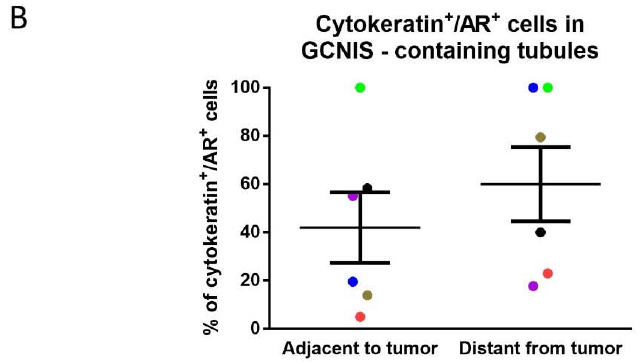
Figure 8. ( A ) Cytokeratin (blue), POU5F1 (GCNIS; red), and androgen receptor (AR, green) expression in Sertoli cells from GCNIS-containing tubules located distant from the tumour and adjacent to the tumour. Dashed lines represent the periphery of the seminiferous tubules. Scale bars represent 50 μ m. Red arrows: cytokeratin + /AR + Sertoli cells, white arrows: cytokeratin − /AR + Sertoli cells. ( B ) Semiquantitative analysis of cytokeratin + /AR + Sertoli cells in GCNIS ‐ containing tubules adjacent and distant to the tumour (n = 6). Mean ± SEM, data analysed by paired t ‐ test. Paired samples from a patient are represented by the same colour.